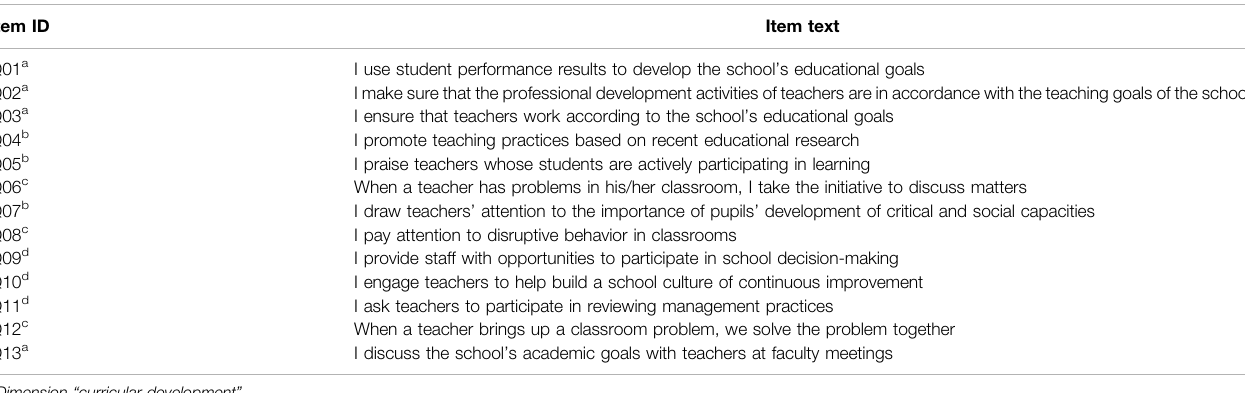
TABLE A2 | Instructional leadership questionnaire items.